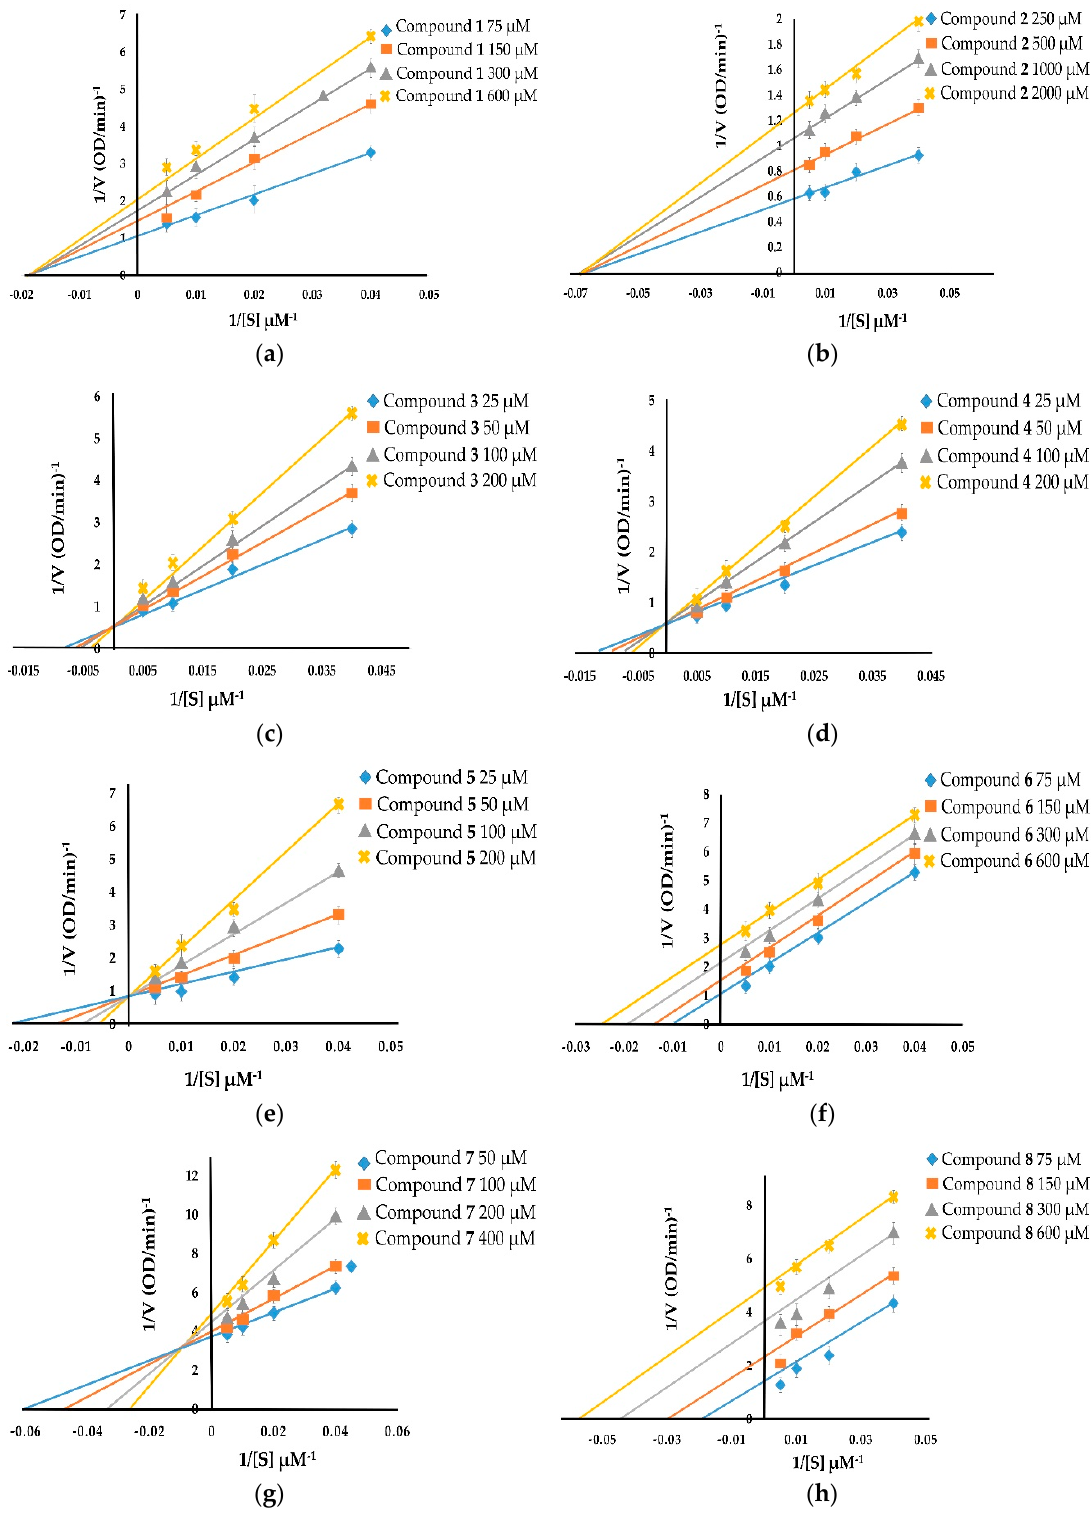
Figure 3. Lineweaver–Burk plots of compounds 1 - 8 showing diphenolase inhibitory activity: ( a ) taraxerol methyl ether ( 1 ); ( b ) spinasterol ( 2 ); ( c ) 6-hydroxyflavanone ( 3 ); ( d ) ( + )-dihydrokaempferol ( 4 ); ( e ) 3,4-dihydroxybenzoic acid ( 5 ); ( f ) taraxerol ( 6 ); ( g ) taraxerone ( 7 ); and ( h ) lupeol acetate ( 8 ).